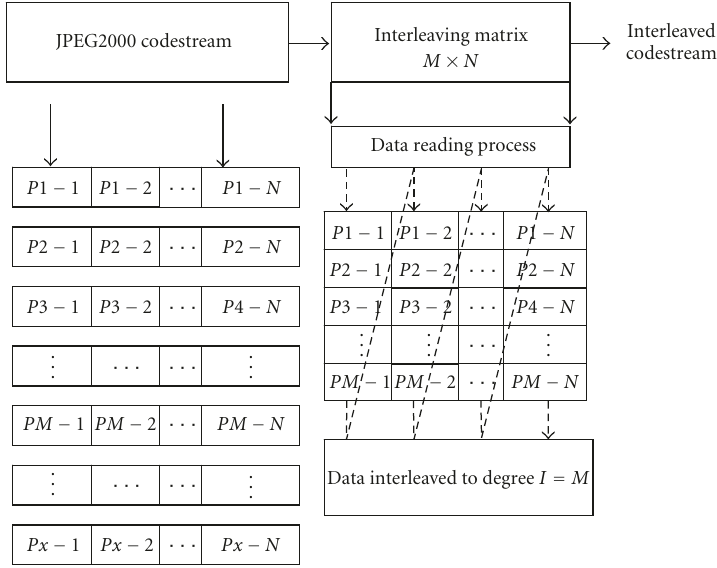
Figure 10: Interleaving process.